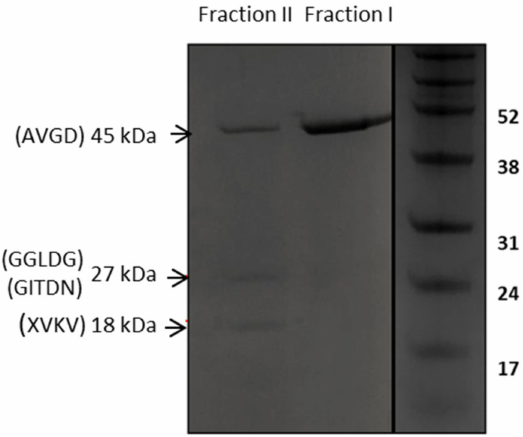
Figure 5. SDS-PAGE analysis of purified His-tagged LysTP712 produced in L. lactis NZ9000. The proteins were eluted from chromatography column at pH 4.5 (fraction II) and pH 5.9 (fraction I). X, amino acid could not be clearly assigned by N-terminal